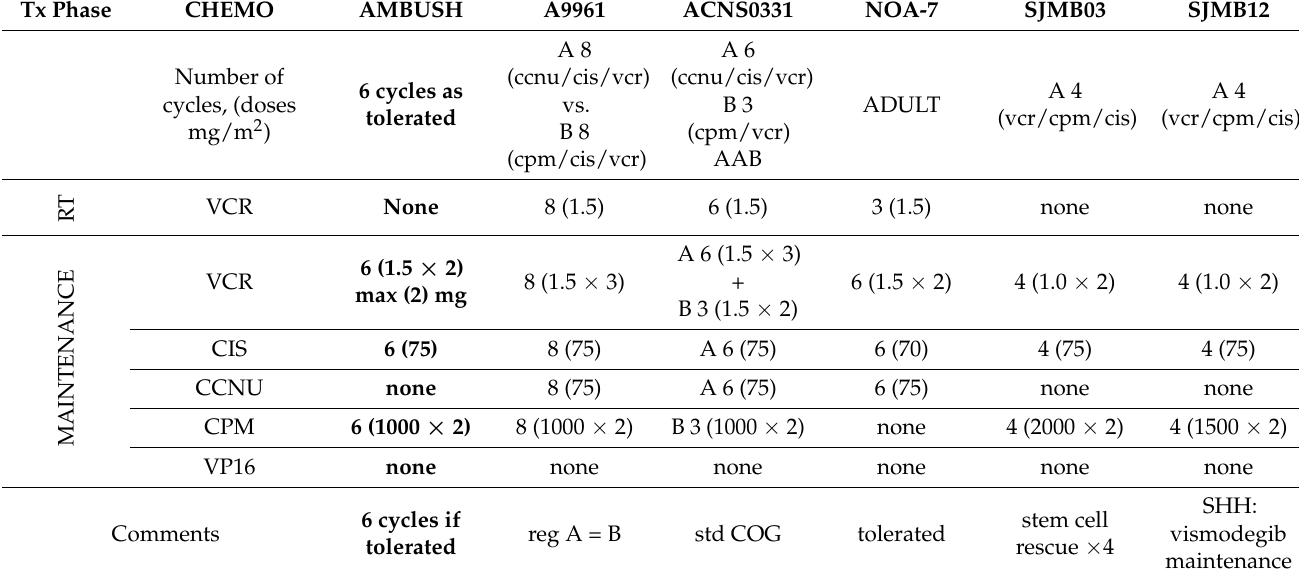
Table 1. Chemotherapy agents that are used in the treatment in average-risk medulloblastoma with final AMBUSH regimen in comparison to other recently reported and ongoing trials.